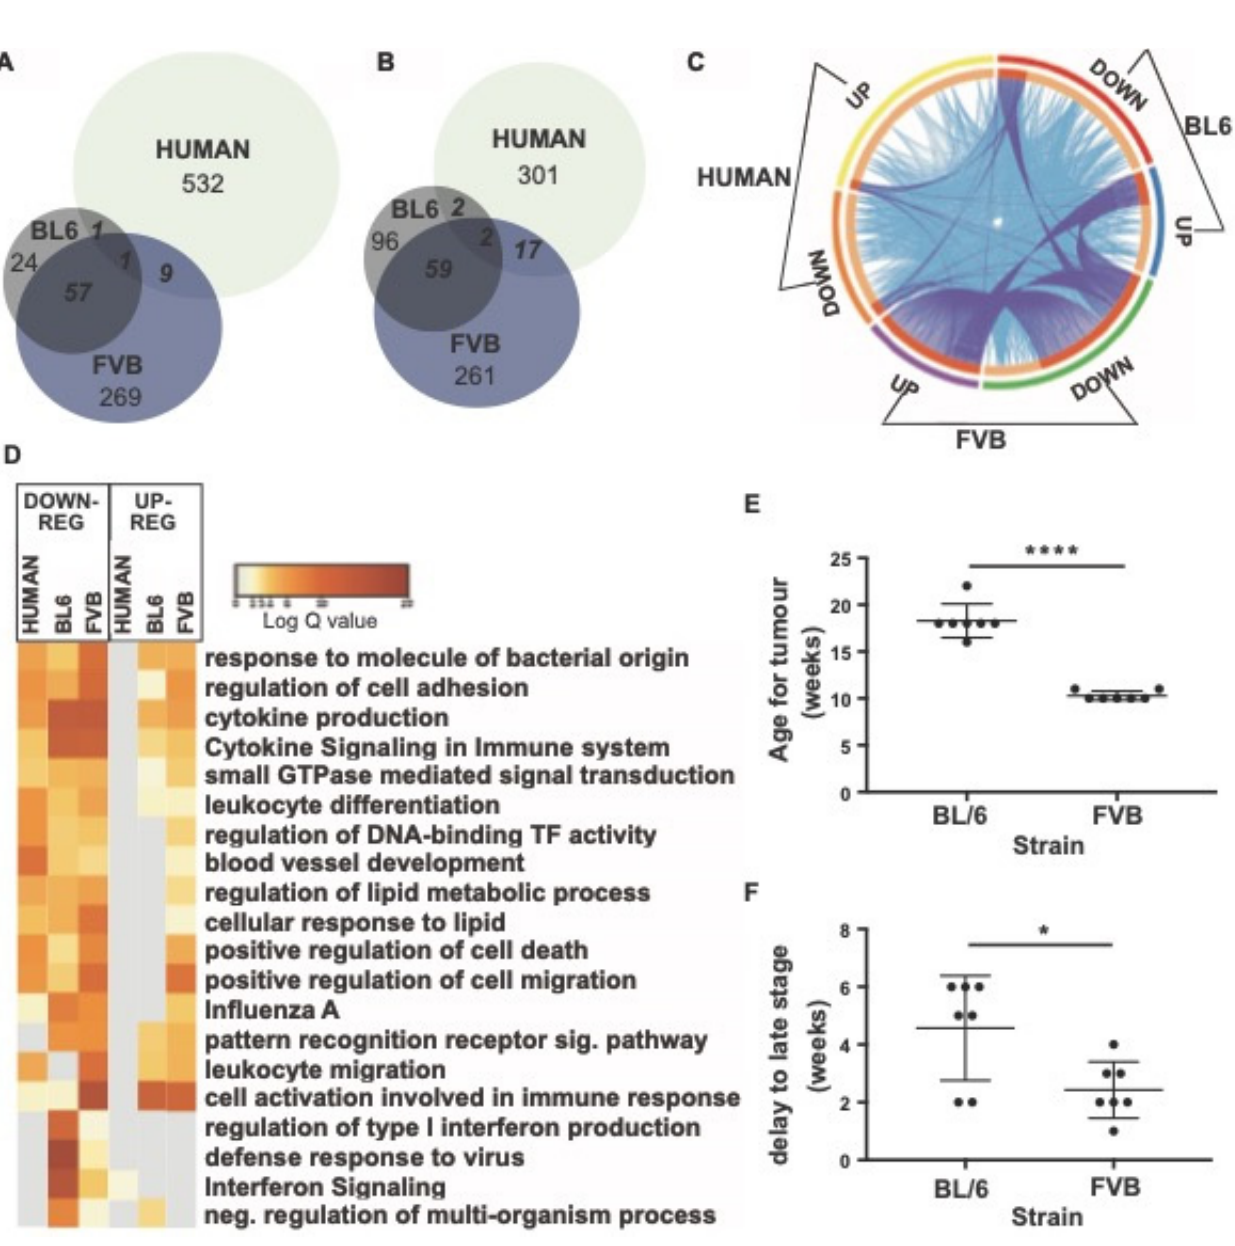
Figure 7. Comparison of DEGs of blood monocytes between cancer and control samples in mouse strains (FVB and C57BL/6) and humans. ( A ) Venn diagram of up-regulated DEGs in Ly6Chigh monocytes. ( B ) Venn diagram of down-regulated DEGs in Ly6Chigh monocytes. ( C ) Circos plot showing commonly enriched genes. The outer arcs represent which DEG gene list is featured: BL6: down-regulated (red arc), up-regulated (blue arc), FVB: downregulated (green arc), up-regulated (purple arc), human: down-regulated (orange arc), upregulated (yellow arc). The inner arcs reflect whether the genes are common to all three (colored in dark orange) or whether genes are common to just two groups (colored in light orange). On each occasion that a gene is in common between a group, a purple line occurs between where the gene occurs on the respective arcs. On each occasion a gene belongs to the same enriched ontology term as another gene in another group, a blue line occurs between where the gene occurs on the respective arcs. ( D ) Pathways for shared genes. Each column represents human, BL6, or FVB DEGs. Columns are grouped into pathways that were down-regu- lated (left) or up-regulated (right). Log q.values are plotted and each bar colored according to the log q.value on a scale of 0 to 20, represented with graduating intensity from cream to dark brown. Gene Ontology or KEGG terms are annotated. ( E ) Age of onset of tumor development in BL6 and